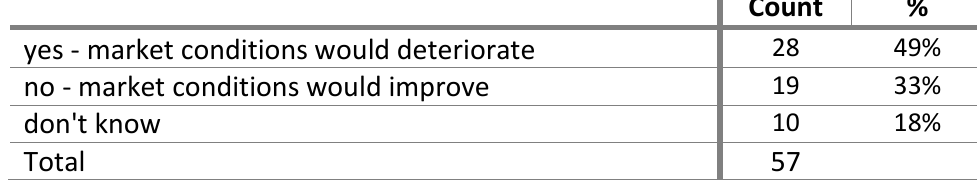
Table 18: Market condition expectations in